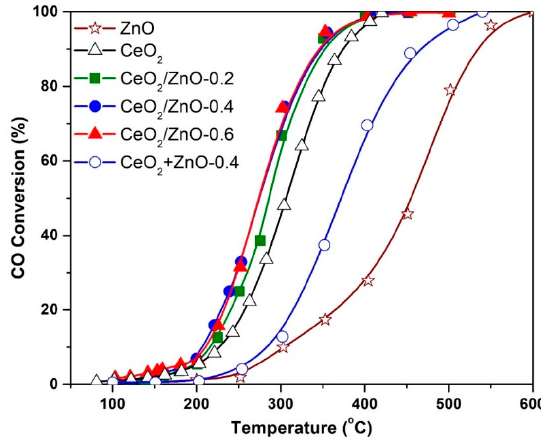
Figure 6. CO conversion profiles of CeO 2 , ZnO and CeO 2 /ZnO samples.